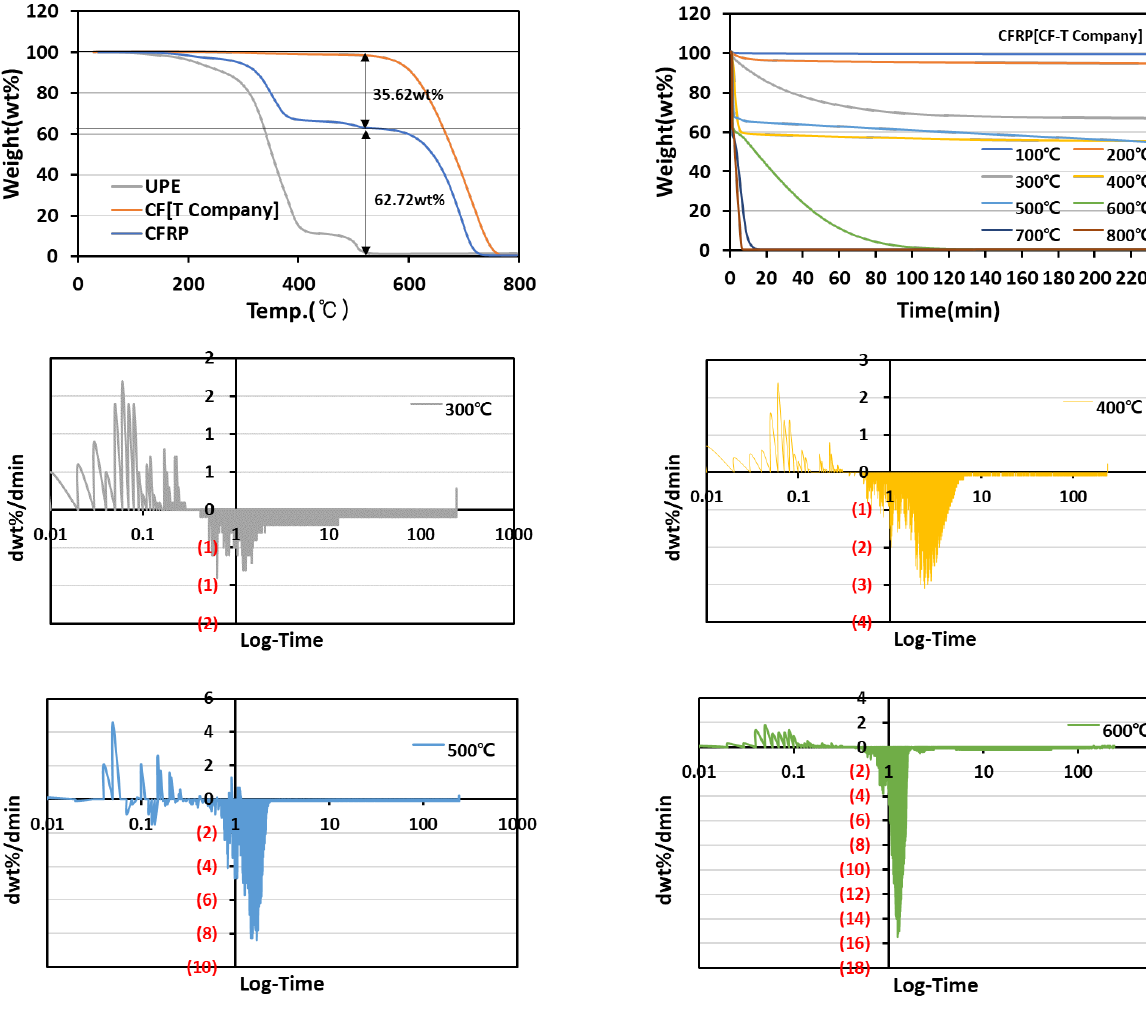
Figure 2. CFRP[CF-T Company] weight change and heat treatment time according to pyrolysis Figure 2. CFRP [CF-T Company] weight change and heat treatment time according to pyrolysis temperature.